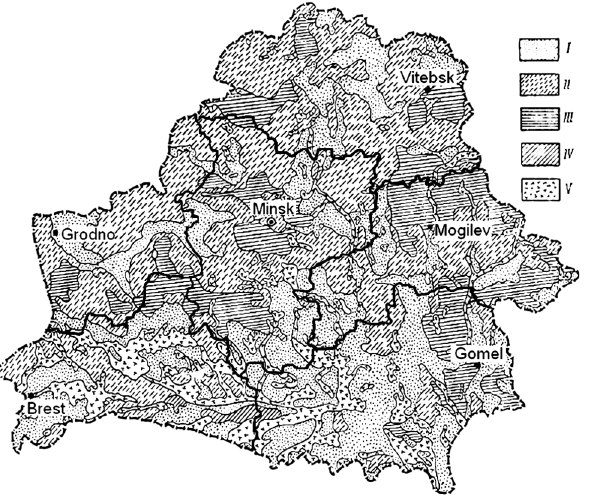
Fig 1. Content of iodine in soil of Belarus (mg/kg). I: 0.56 – 0.64; II: 0.87 – 0.94; III: 1.3 – 1.39; IV: 1.6 – 4.2; V: 5.0 – 18.2. The original map is derived from ref. [43] and is presented with minor modifications.